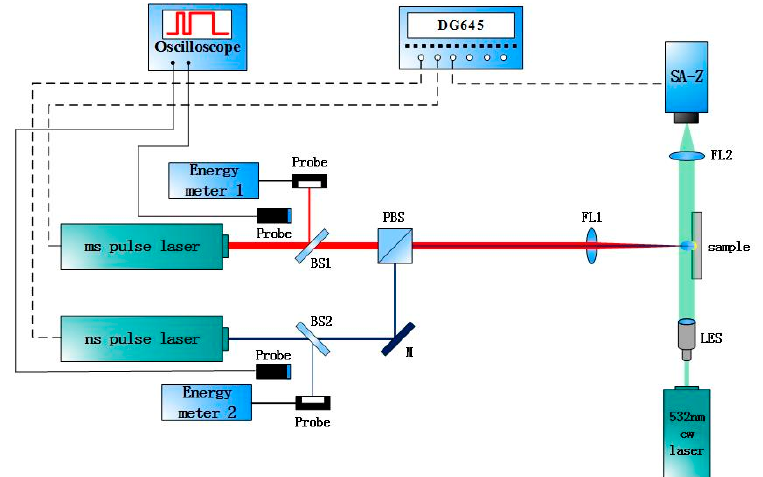
Figure 1. Experimental setup for ms-ns pulse combination laser processing of aluminum alloy.